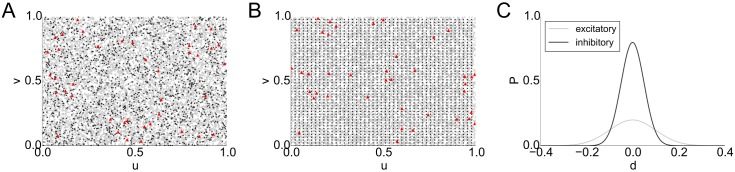
Topographic network with local connectivity on a torus.
A, B: Positions (u, v) of 10,000 cells on a torus (left and right, top and bottom edges are identified), excitatory cells shown as gray triangles, inhibitory cells as black stars, driver cells in red. A: Uniformly distributed excitatory and inhibitory cells. B: Inhibitory cells grid-aligned, excitatory cells uniformly distributed. C: Local connectivity profiles of excitatory and inhibitory cells.